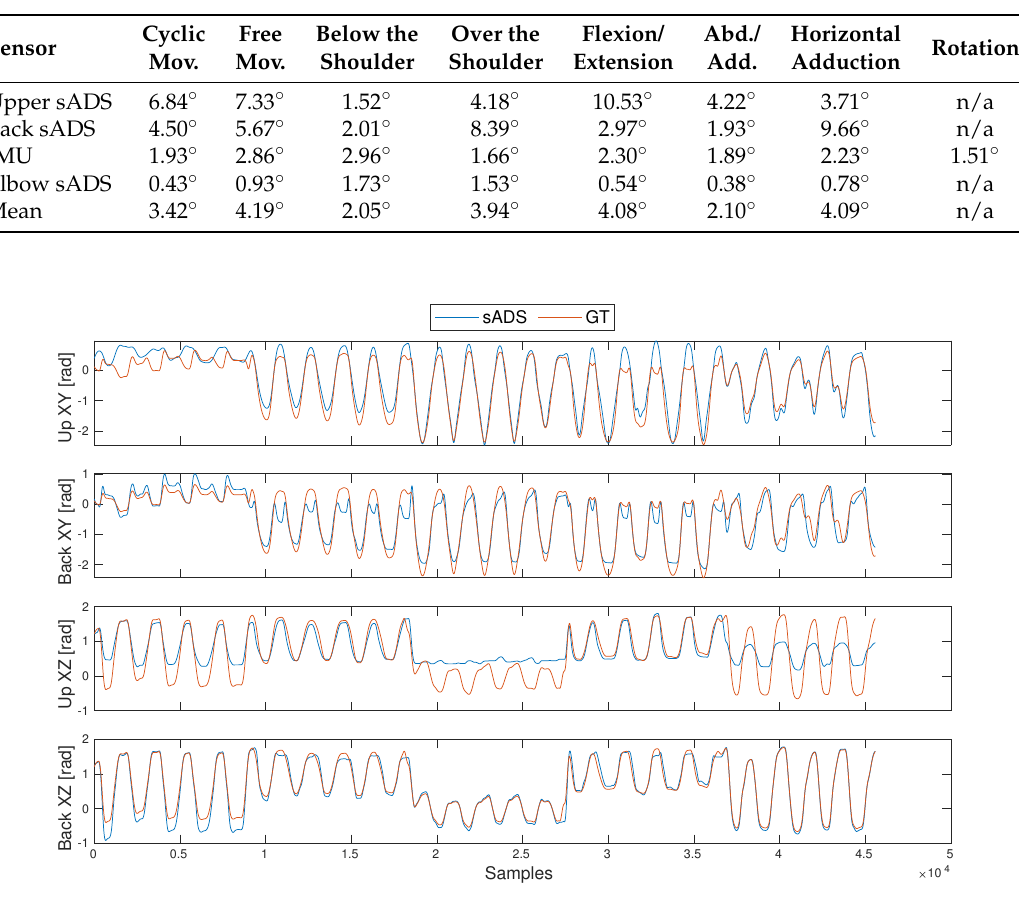
Figure 7. Performance of the sADS angles compared with the GTS in a series